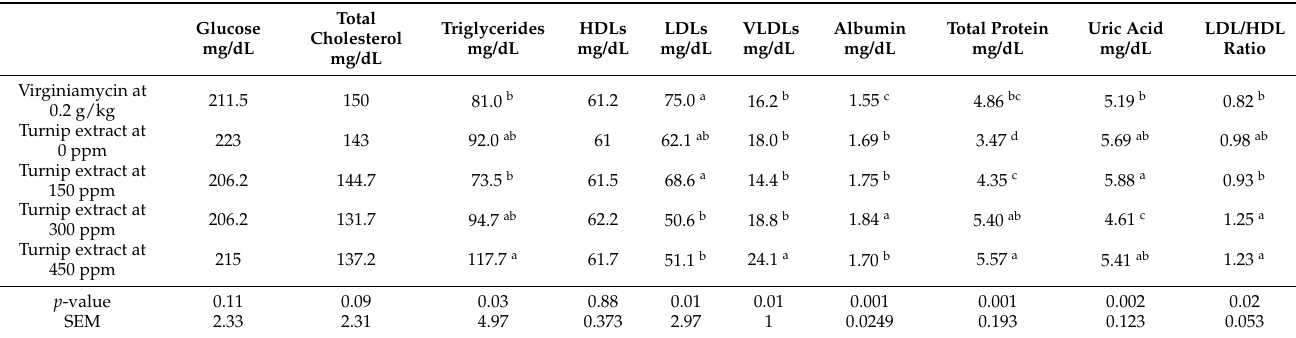
Table 5. Mean (log 10 ) antibody response titers to sheep red blood cells at 28 and 42 d of age in Ross 308 broilers supplemented with different levels of Brassica rapa extract at 0–450 ppm or Virginiamycin from weeks 1–6 *. Virginiamycin at 0.2 g/kg Turnip extract at 300 ppm Turnip extract at 450 ppm